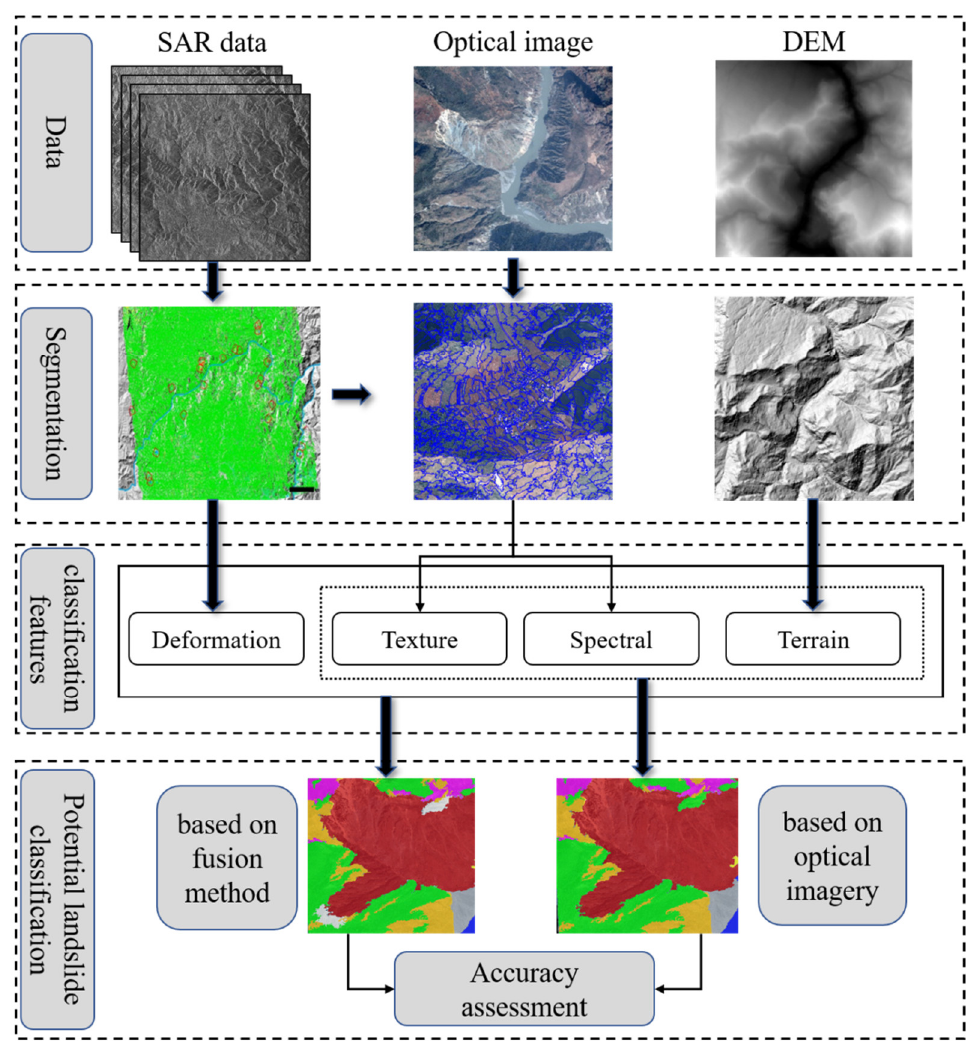
Figure 3. The flowchart of the proposed method for potential landslide extraction.